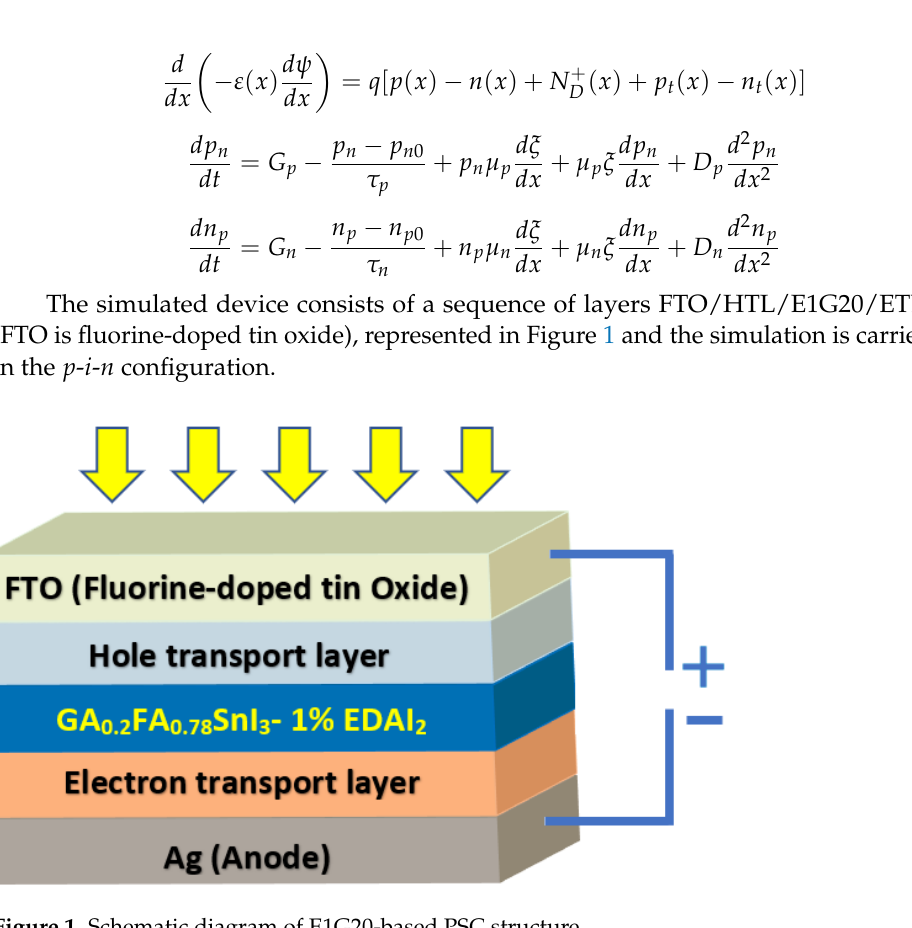
Figure 1. Schematic diagram of E1G20-based PSC